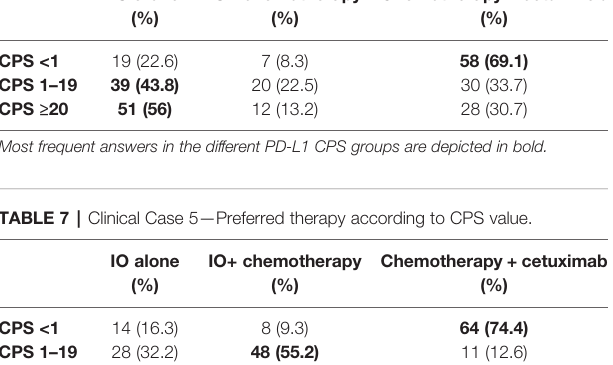
TABLE 6 | Clinical Case 4 — Preferred therapy according to CPS value.